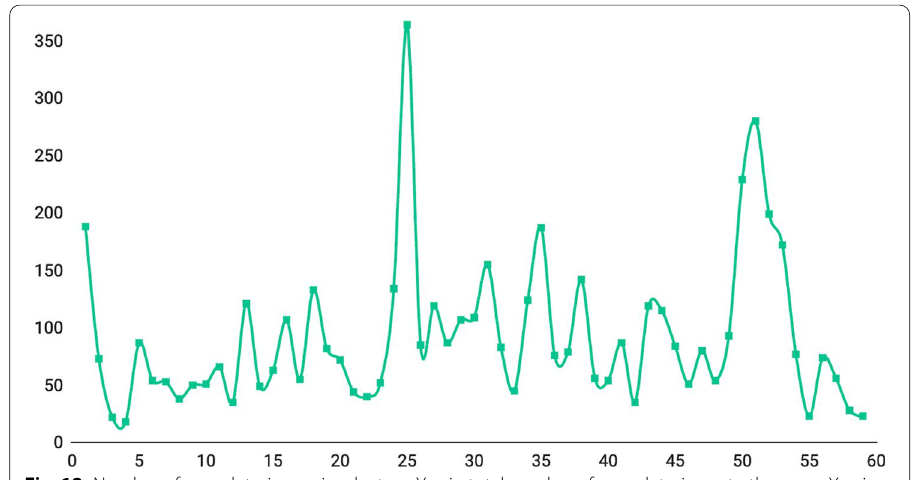
Fig. 12 Number of complete-jumps in a lecture. Y-axis: total number of complete-jump to the page, X-axis: the page number of the lecture